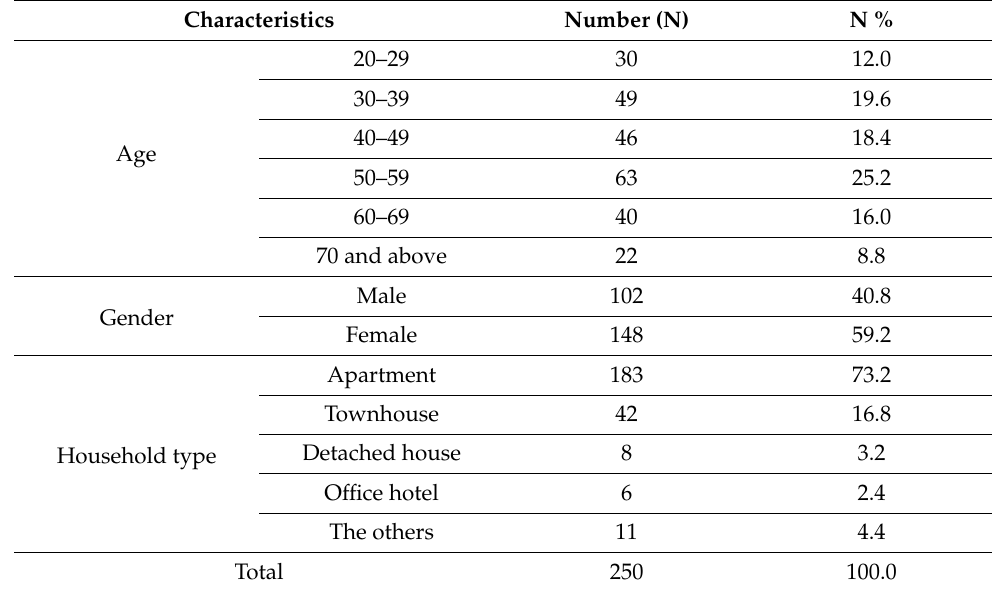
Table 3. Descriptive statistics of demographic